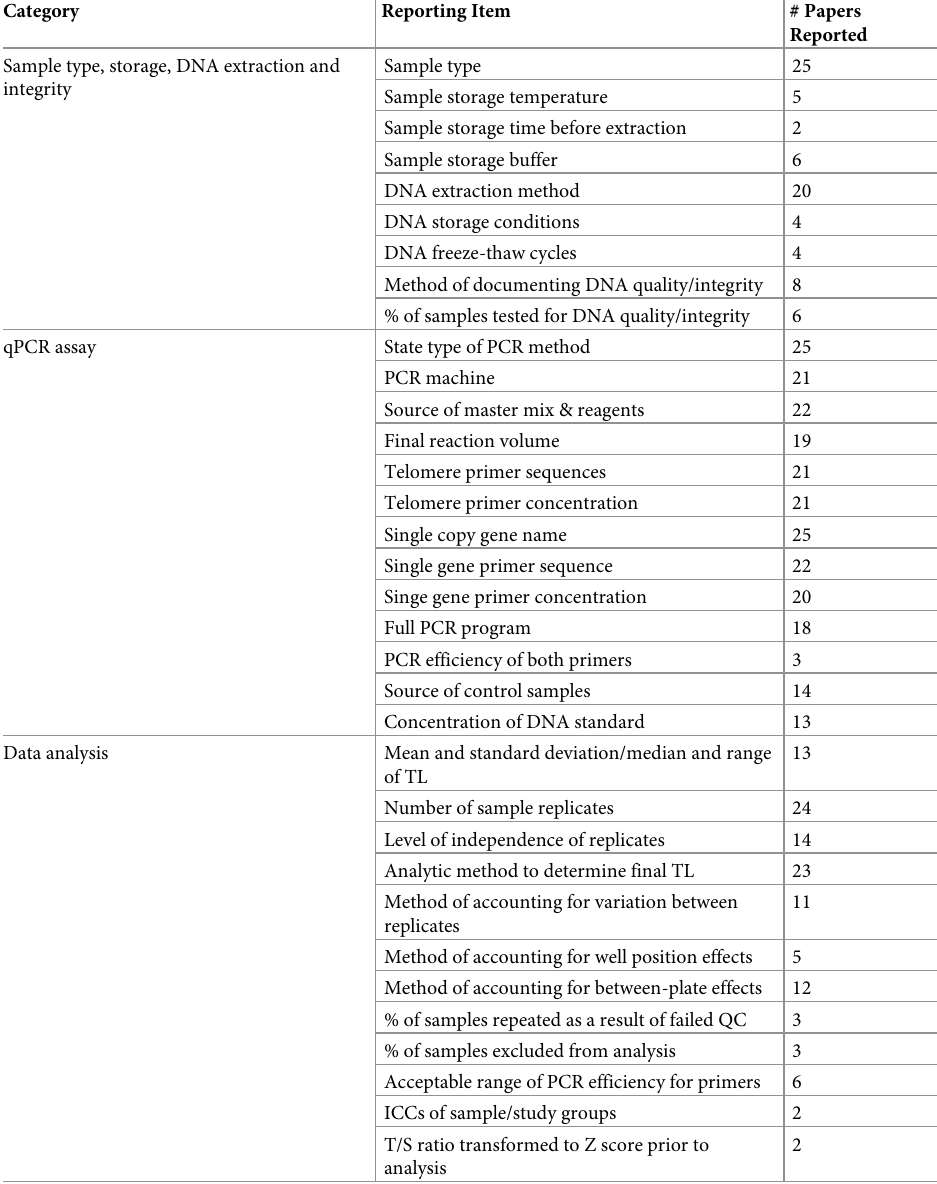
Table 3. Item-specific reporting results of the TRN reporting